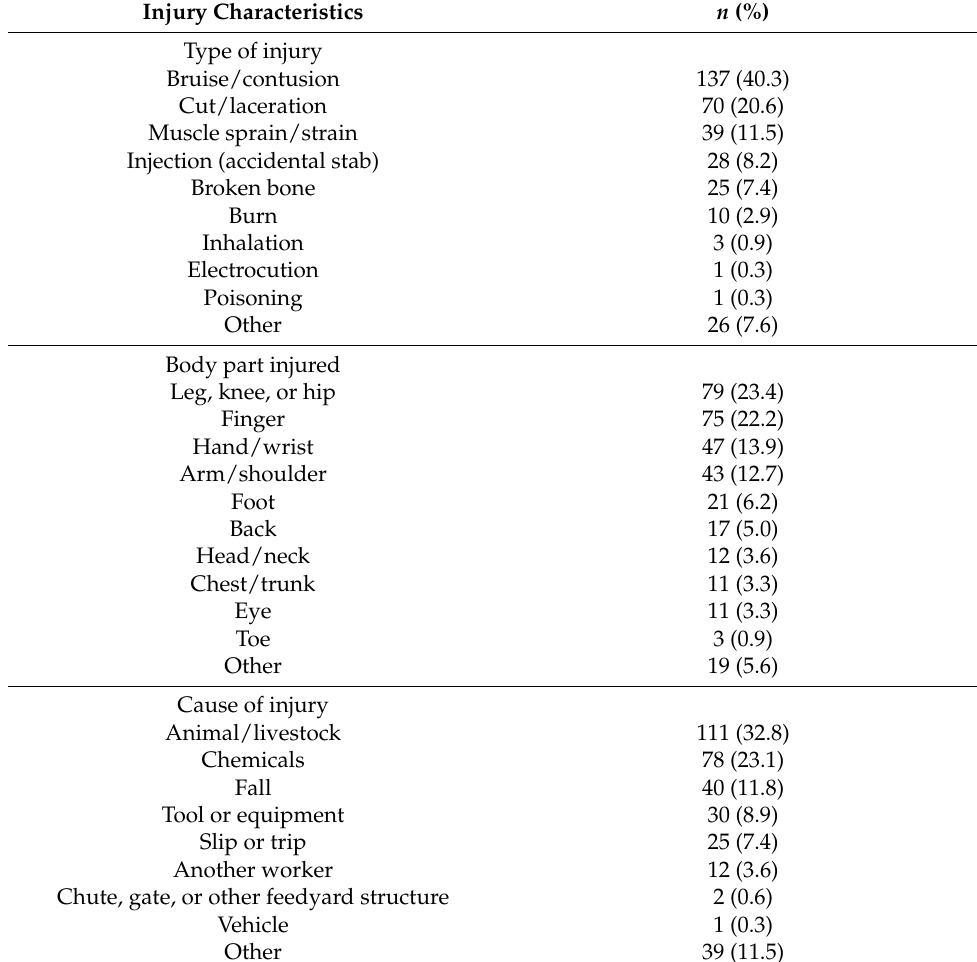
Table 2. Frequencies of reported injuries by injury